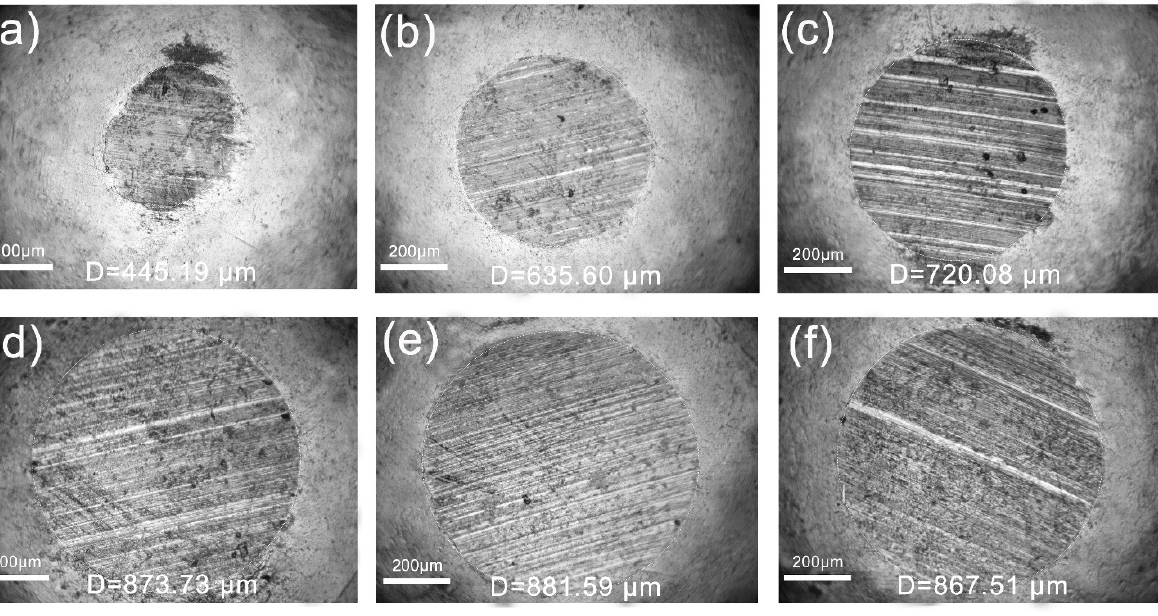
Figure 14. Wear rates and WSD of greases with different consistencies: ( a ) WSD, ( b ) wear rates.